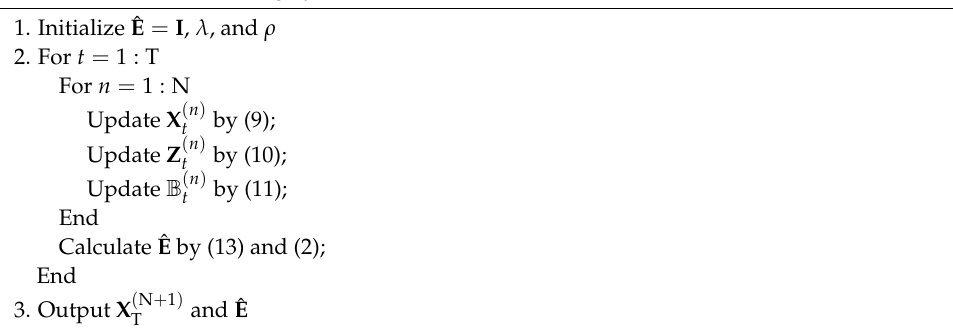
Algorithm 1. Autofocusing by 2D-ADMM